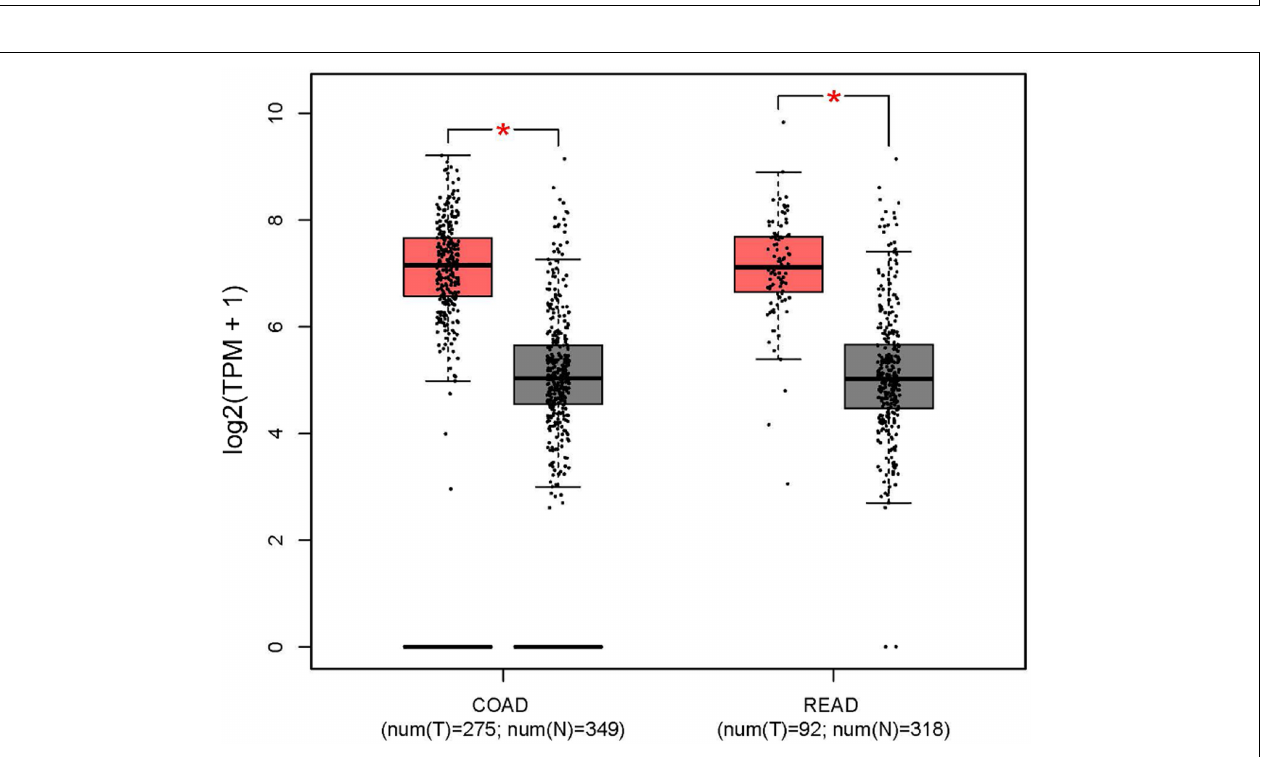
FIGURE 11 | MYC expression level in colon and rectal cancer from the GEPIA database (red box: tumor; gray box: normal). COAD, colon adenocarcinoma; READ, rectum adenocarcinoma.